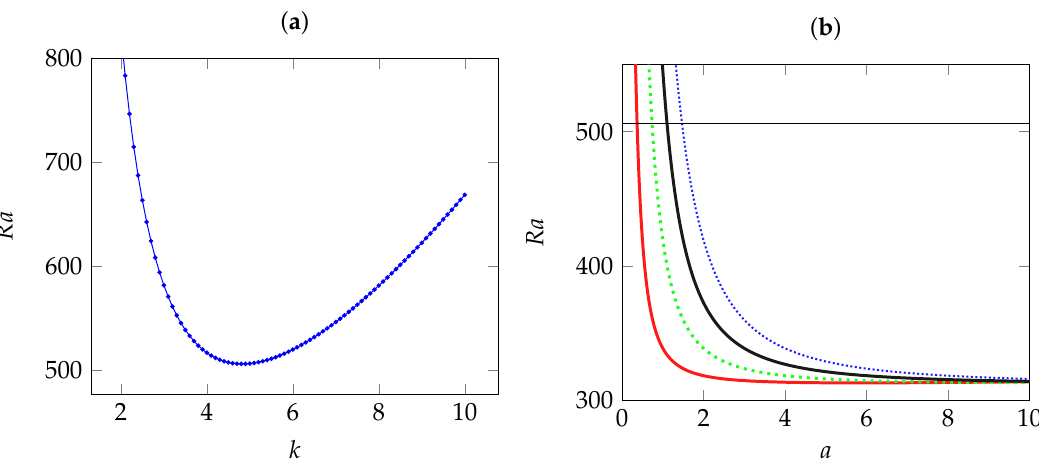
Figure 6. Newtonian fluids: ( a ) neutral stability curve at the onset of oscillatory transverse rolls; ( b ) critical Rayleigh number at the onset of steady longitudinal rolls against the lateral aspect ratio with different numbers of rolls ( L = 1: red dashed curve; L = 2: green dotted curve; L = 3: black dash dotted curve; and L = 4: blue densely-dotted curve). The horizontal line corresponds to the threshold of oscillatory transverse rolls.